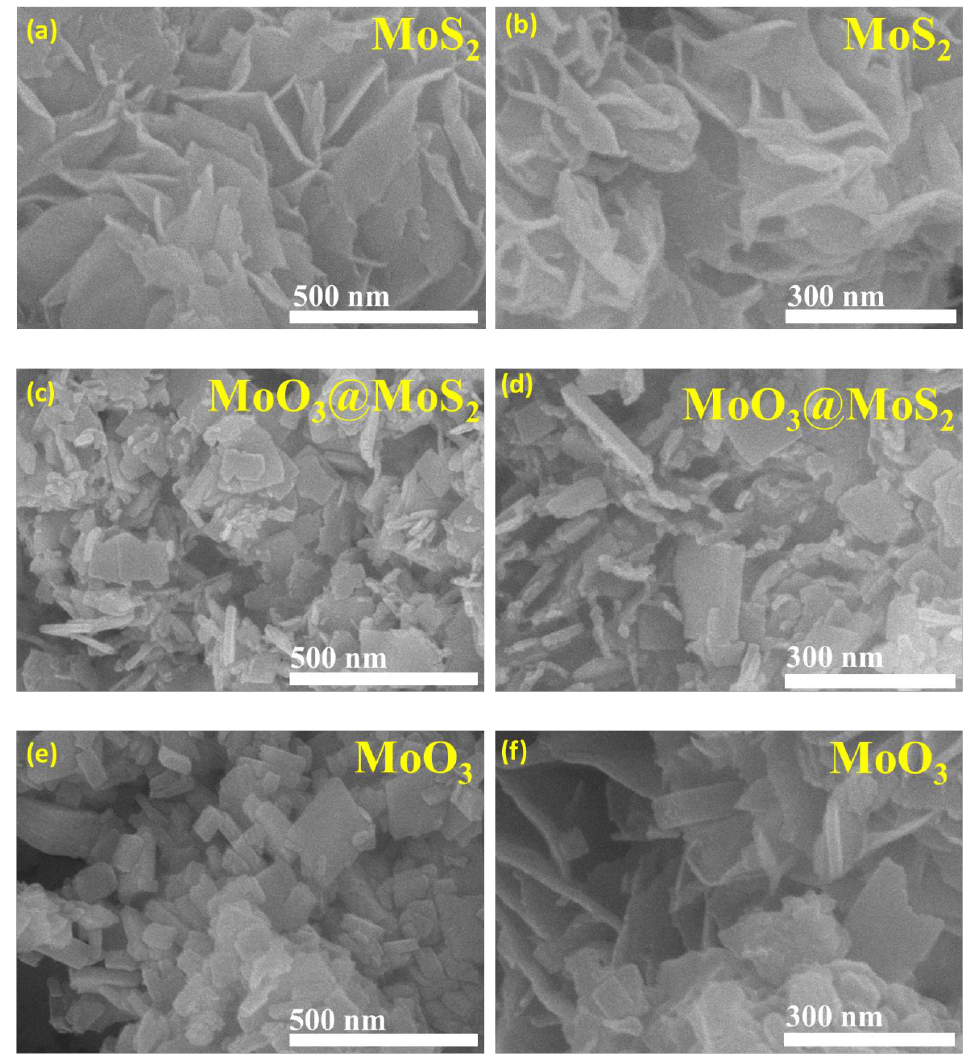
Figure 1. FE-SEM images for ( a , b ) MoS 2 , ( c , d ) MoO 3 @MoS 2 , and ( e , f ) MoO 3 . Synchrotron-based high-resolution powder diffraction (HRPD) was used to investi- gate the crystal structure of the MoS 2 , MoO 3 @MoS 2 , and MoO 3 samples, as presented in Figures 2a and S2. The characteristic peaks of the MoS 2 sample annealed at 200 °C match very well with those of the hexagonal-structured 2D MoS 2 with the space group P 6 3 / mmc (JCPDS # 37 – 1492), while the intense XRD peaks for MoO 3 annealed at 300 °C confirm the formation of a highly crystalline α -MoO 3 phase with an orthorhombic structure and space group Pbnm (JCPDS # 35 – 0609). Notably, the MoO 3 @MoS 2 sample annealed at 250 °C ex- hibits the diffraction peaks corresponding to both hexagonal MoS 2 and orthorhombic MoO 3 phases, verifying the hybrid structure formation. Notably, the MoO 3 peak intensity in the MoO 3 @MoS 2 hybrid was relatively lower than that of the MoO 3 sample heated at 300 °C, suggesting the relatively lower content of the MoO 3 than the MoS 2 . Figure S3a – c depicts the HRPD profile matching data of MoS 2 , MoO 3 @MoS 2 , and MoO 3 . The as-pre- pared hybrid material perfectly matches and contains the well-positioned diffraction peaks of MoS 2 and MoO 3 . The lattice volume (v) of the MoS 2 component in MoO 3 @MoS 2